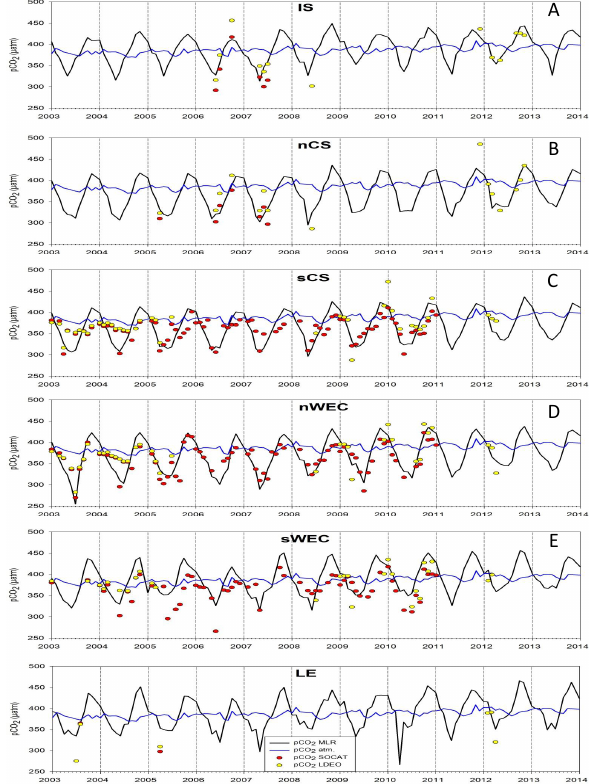
Figure 8. Time series of monthly p CO 2,MLR (µatm, in black) av- eraged over IS, nCS, sCS, nWEC, sWEC and LE provinces from 2003 to 2013. Monthly mean corresponding to SOCAT data (red dots) and LDEO data (yellow dots) are shown for comparison. The blue lines represent the atmospheric p CO 2